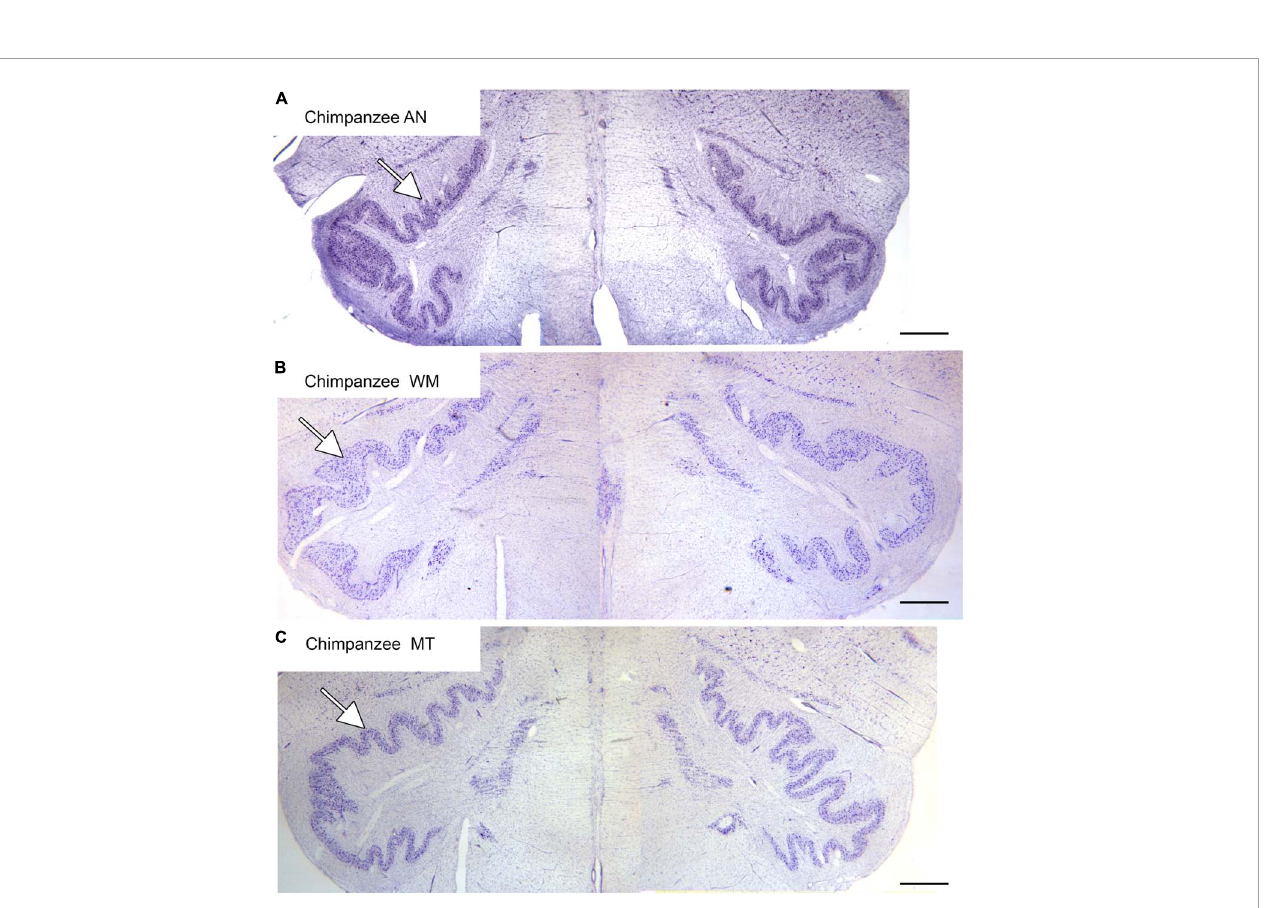
FIGURE4 The IOpr in the chimpanzee. The IOpr (arrows) in three different chimpanzees, AN (A) , WM (B) , and MT (C) . The folding pattern is much more complex than in the species shown in Figure 3 . Further, the shape and folding pattern of the IOpr is different for each animal, and there is left-right asymmetry all three animals. Scale bars: (A–C) = 1